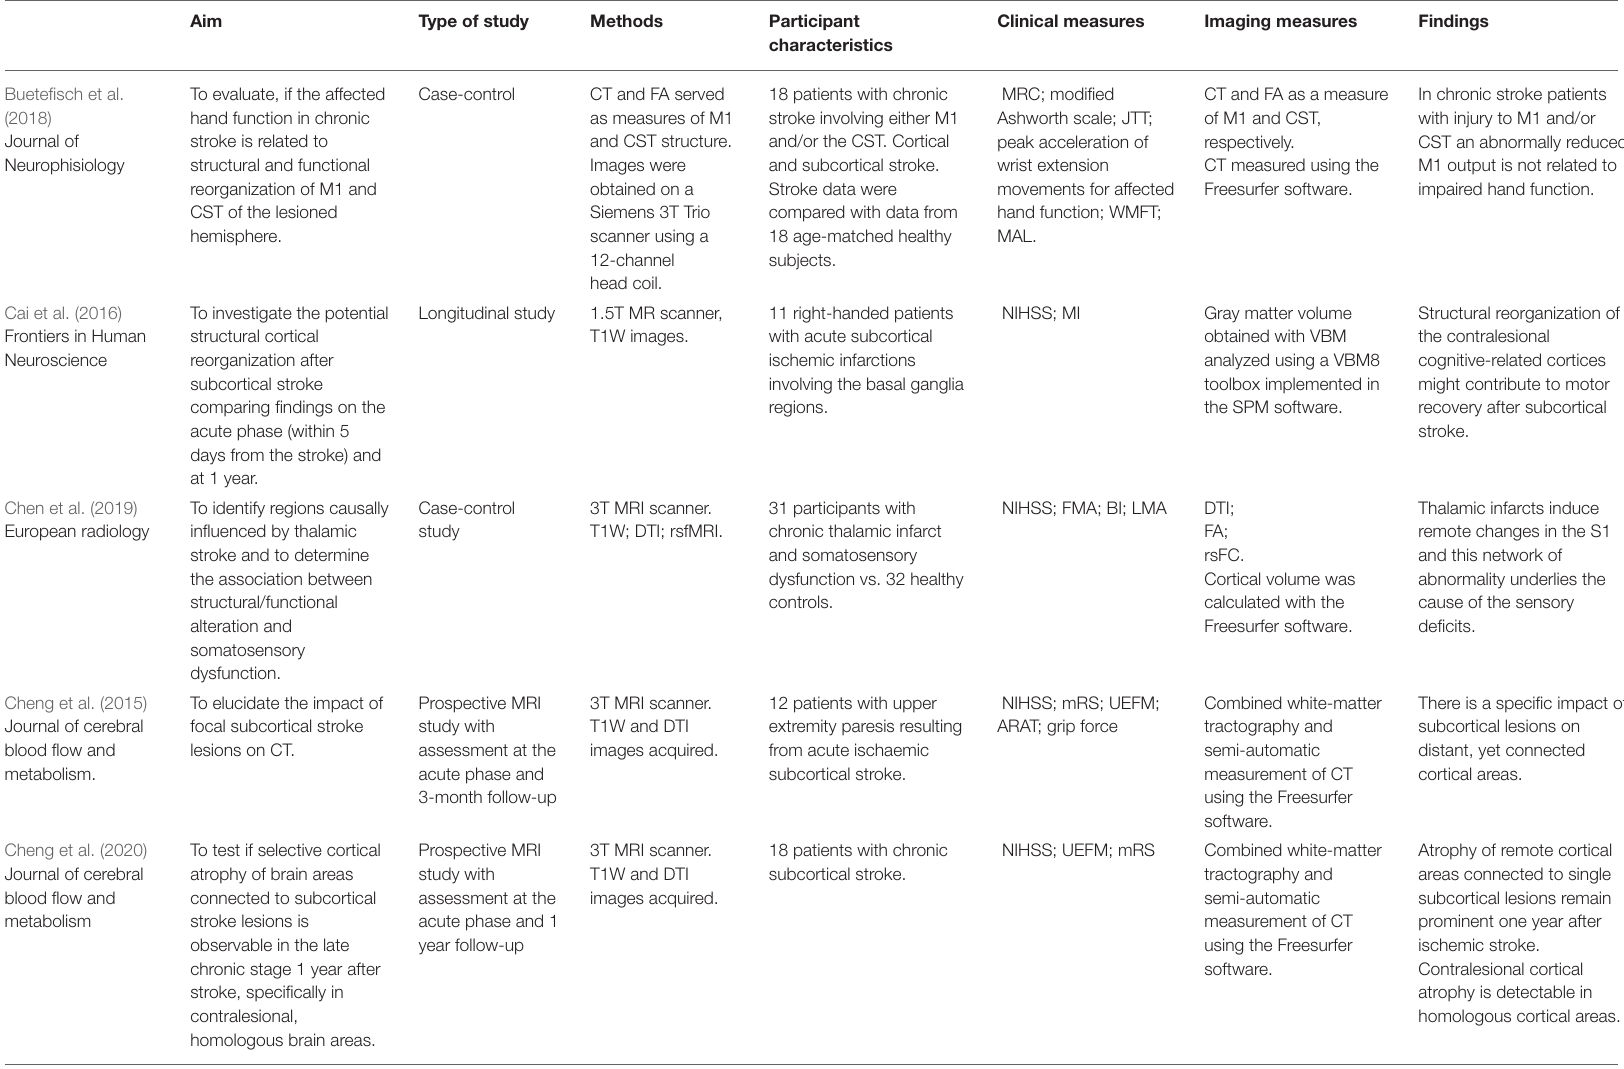
TABLE 1 | Characteristics of included